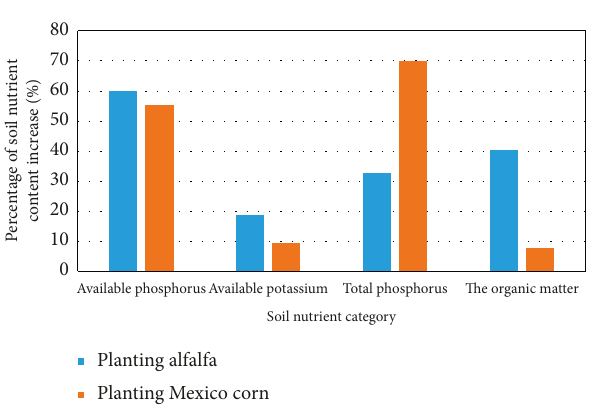
Figure 6: Physical and chemical indicators of the selected soils.